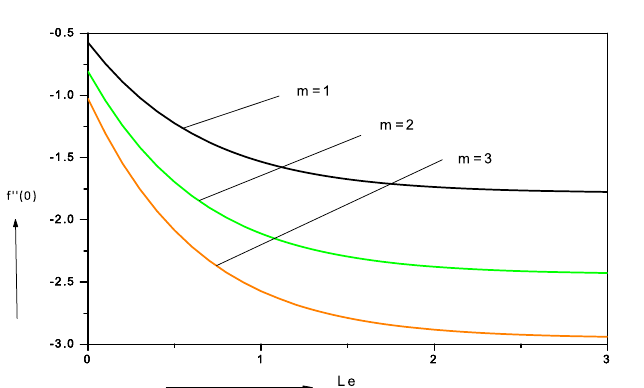
Figure 13. Variation of reduced skin friction coefficient with Lewis number ( Le ) in water-based